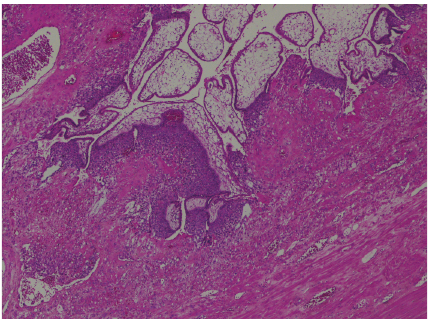
Figure 4: Histopathology: placenta increta with myometrial fibers immediately apposed to placental villi in the absence of intervening